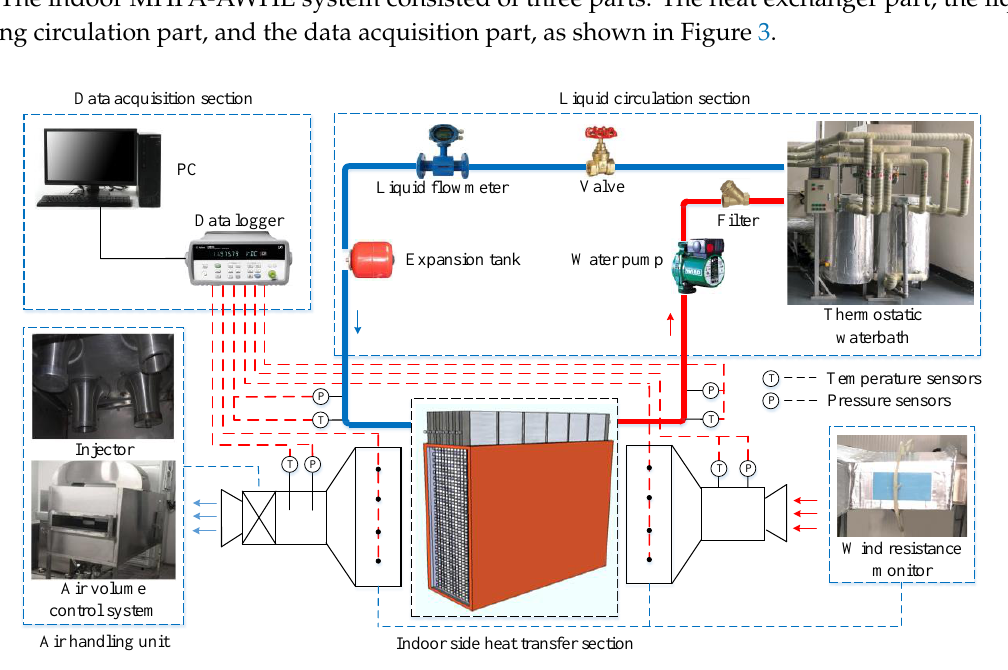
Figure 2. MHPA-AWHE.